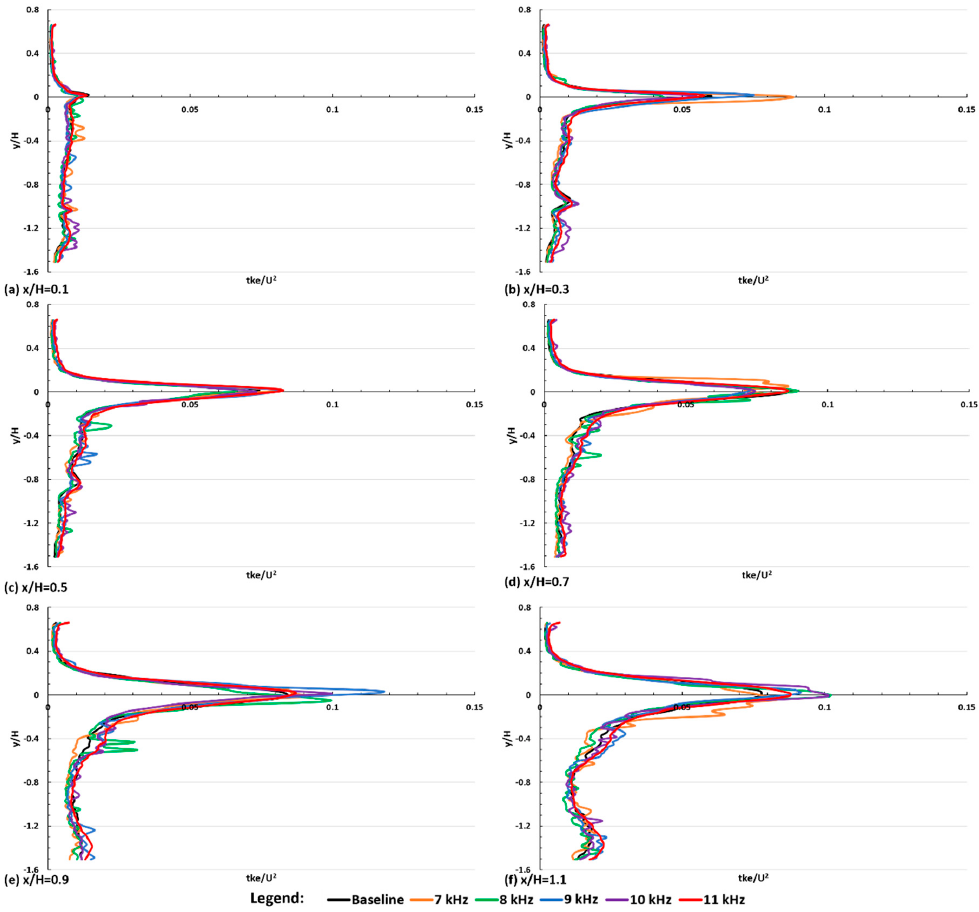
Figure 15. Normalised turbulence kinetic energy profiles measured at various normalised x-locations along the wake region. x/H = ( a ) 0.1, ( b ) 0.3, ( c ) 0.5, ( d ) 0.7, ( e ) 0.9, and ( f ) 1.1. Further downstream of the trailer rear end, at x/H = 0.9 (Figure 15e) and 1.1 (Figure 15f), the fluctuation of the turbulence kinetic energy levels is even stronger between − 1.5 < y/H < 0.4 (i.e., below the upper shear layer) in those trailers with the linear AC-DBD plasma actuation being implemented. The linear AC-DBD plasma actuation generally increases the turbulence kinetic energy levels along